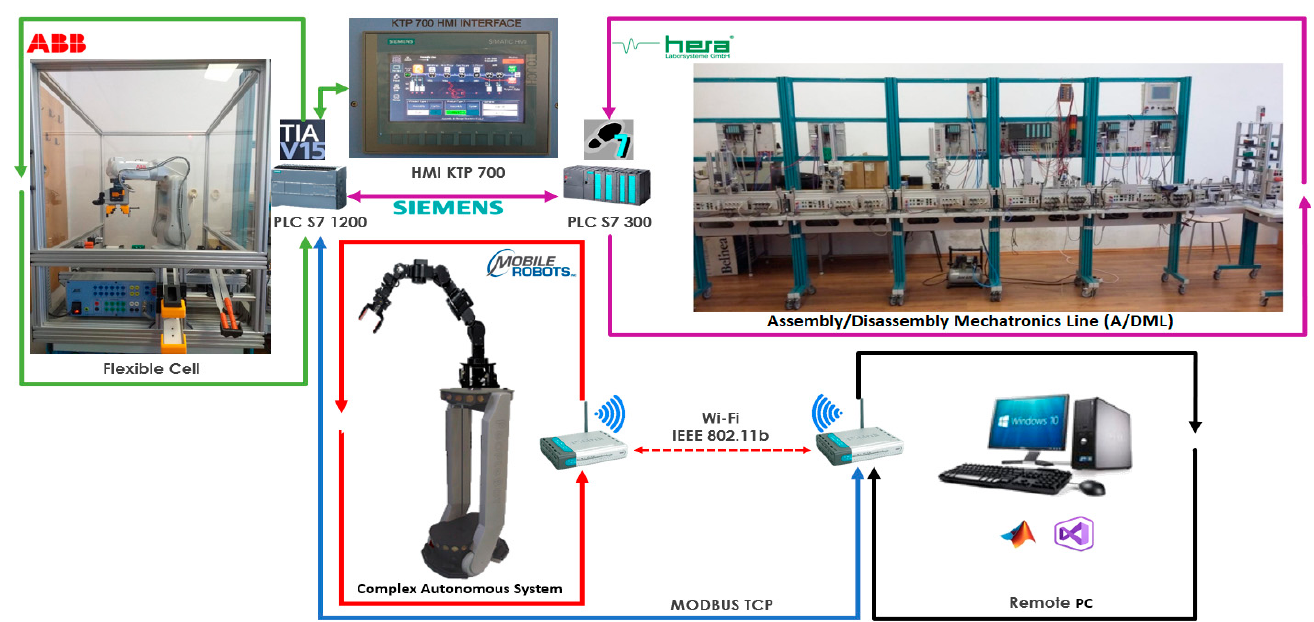
Figure 1. Control structure of A/DML Hera&Horstmann, FC with ABB IRM and CAS with PeopleBot WMR and Cyton 1500 RM.